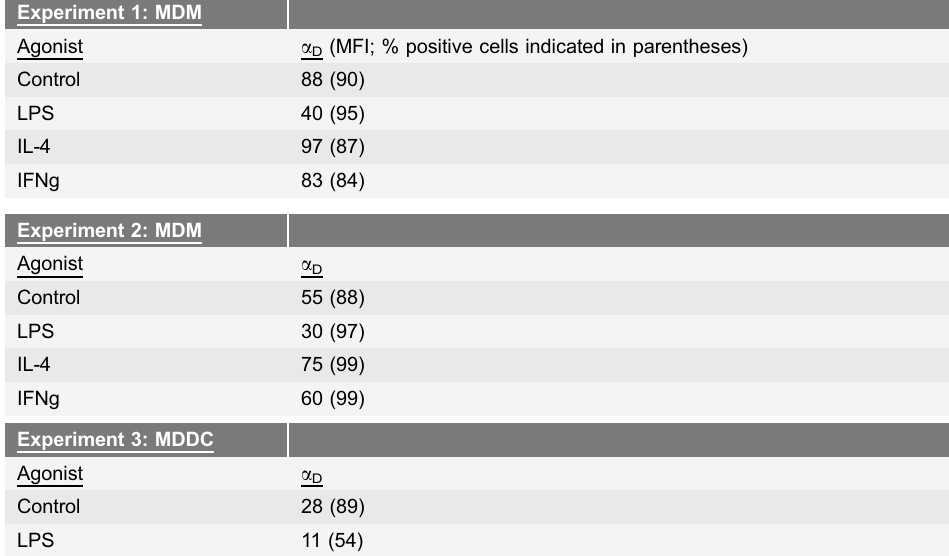
Table 1. Integrin a D b 2 is Dynamically Expressed by Human Monocyte-derived Macrophages (MDM) and Dendritic Cells (MDDC). Experiment 1: